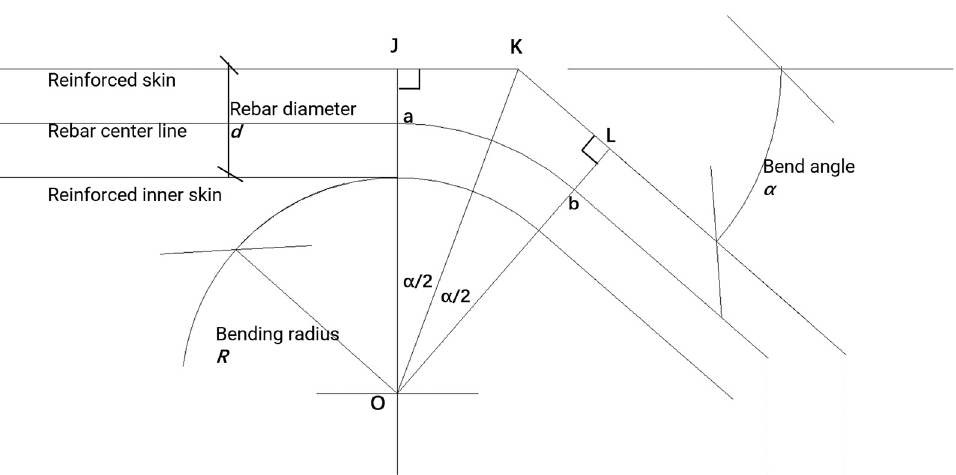
Figure 10. Schematic diagram of the calculation of the steel bar cutting length.